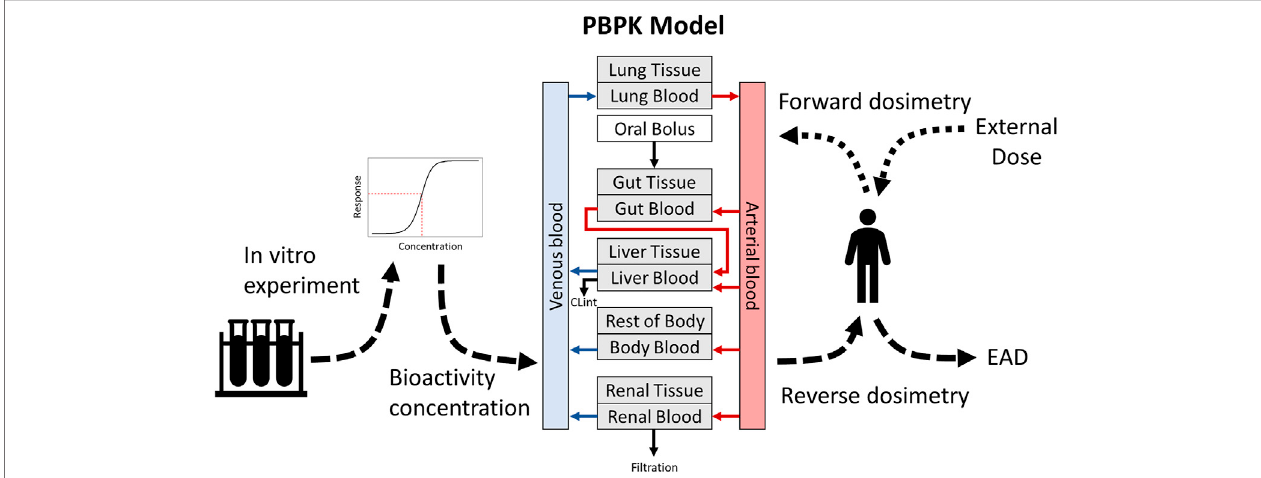
FIGURE 1 | Overview of the uses of PBPK modeling for dose prediction and IVIVE. Dotted lines show forward dosimetry for predicting relevant doses from an external exposure, while dashed lines show reverse dosimetry for IVIVE and prediction of EADs.